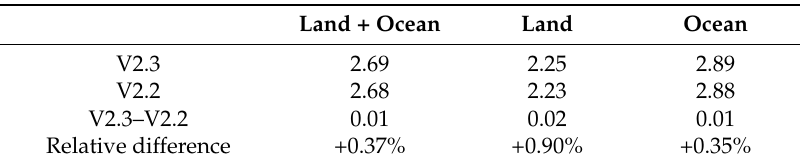
Figure 2. Time series of GPCP V2.2 (black) and V2.3 (red) mean precipitation anomalies (40 ◦ N–40 ◦ S) based on the 1979–2013 GPCP V2.2 climatology. Table 1. Global mean precipitation (P, mm day − 1 ) from the Global Precipitation Climatology Project (GPCP) V2.3 and V2.2 and their differences from 1979–2013.